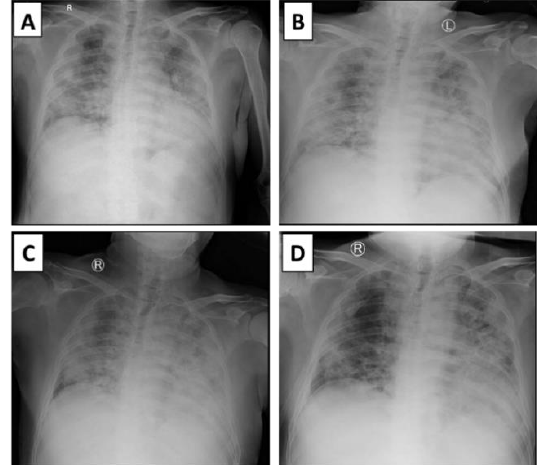
Figure 3. The development of the chest X-ray of the third patient Description: A. The results of the initial chest X-ray showed a typical due to viral pneumonia with partial infiltrates with con- solidation in the middle-lower field of the right and left lungs, dominant on the peripheral side. B. The first evaluation chest x- ray still showed a typical due to viral pneumonia with relatively constant infiltrates, where the infiltrates were partially accom- panied by consolidation with a fibrotic component in the upper-middle-lower fields of the right and left lungs, dominant on the peripheral side. C. The second evaluation chest x-ray showed a typical due to viral pneumonia with relatively constant right lung infiltrates but slightly increased left, where the infiltrates were partially accompanied by consolidation with a fibrotic component in the upper-middle-lower fields of the right lung, dominantly on the peripheral side. D. The last chest X-ray showed a typical due to viral pneumonia with partial infiltrates accompanied by consolidation with a fibrotic component in the upper-middle-lower fields of the left lung, dominantly on the peripheral side, which seemed reduced compared to the previous chest